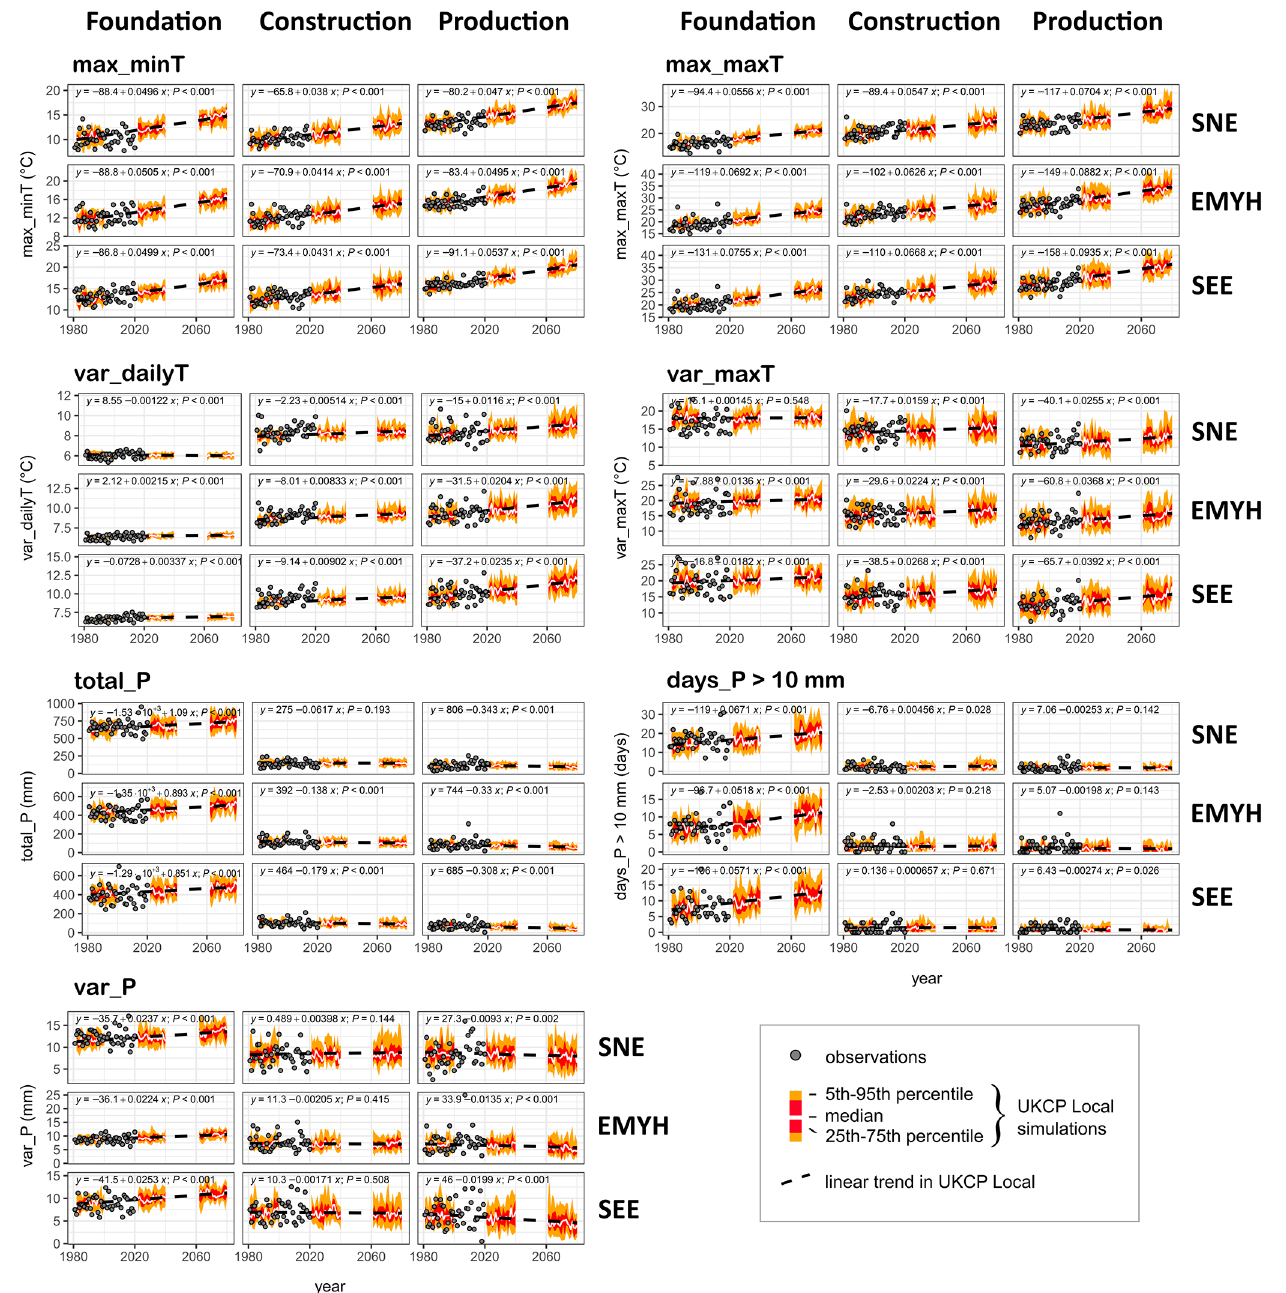
Figure 7. Trends in key climate metrics for the three growth stages (columns) and three regions (rows). Metrics are selected from (and defined in) Table 2: max_minT , max_maxT , var_dailyT , var_maxT , total_P , days _ P > 10mm, and var_P . Dark grey circles indicate observations; colour ribbons are the 12 UKCP Local members (5th–95th percentile in orange, 25th–75th percentile in red, and the median as a white line). Linear trend lines for the UKCP simulations are shown as dashed black lines, along with the regression equation and p value in each